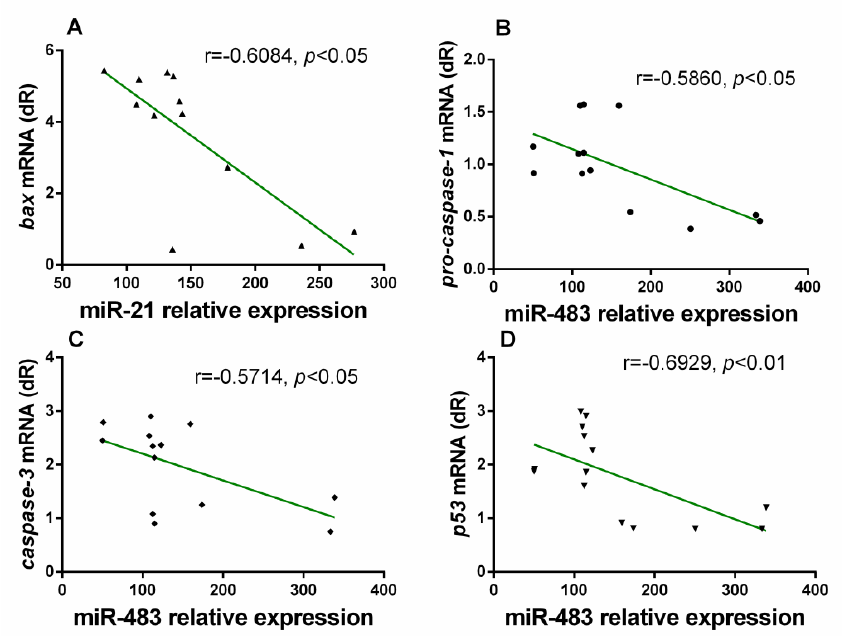
Figure 3. Correlations between miR-21, miR-146a, and miR-223 expression and pro-inflammatory and proapoptotic markers in gastrocnemius muscle of WT mice with aging, calculated using analysis of Spearman correlation coefficient (r). Positive correlations were found between miR-21 expression and pro-IL-1 β , pro-caspase-1, bax and p53 levels ( A – D ). Possitive correlations were detected between miR-146a expression and pro-IL-1 β , caspase-3, bax and p53 ( E – H ). Positive correlations were observed between miR-223 and pro-IL-1 β , caspase-3, bax and p53 ( I – L ).